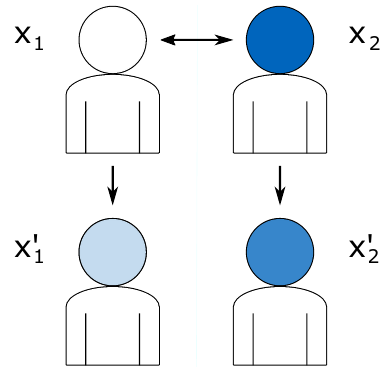
Figure 1. Illustration of opinion exchange according to the Deffuant–Weisbuch model; darker shades of blue correspond to higher values on the opinion scale x